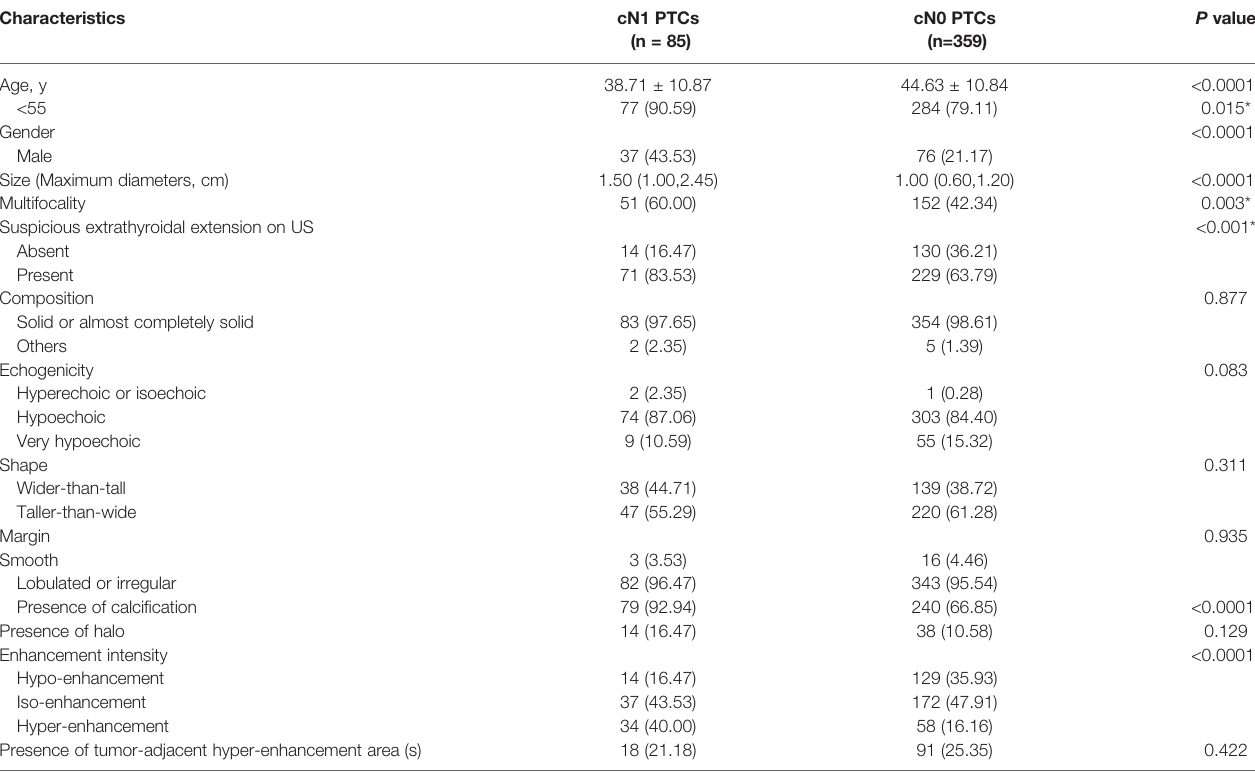
TABLE 1 | Clinical and sonographic characteristics of cN1 PTCs and cN0